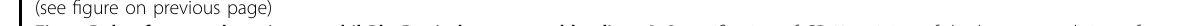
Fig. 4 Role of macrophage/neutrophil Plg-R KT in burn wound healing. A Quanti fi cation of CD68 staining of the burn wound tissue from Plg- R KT − / − and Plg-R KT + / + littermates for macrophages, ( n ≥ 3). Robust ANOVA showed a signi fi cant effect for time ( p < 0.0001, f = 24.180), but not